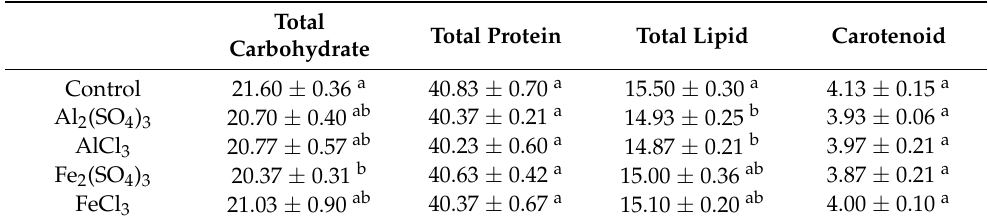
a, b Duncan’s test, alpha = 0.05.